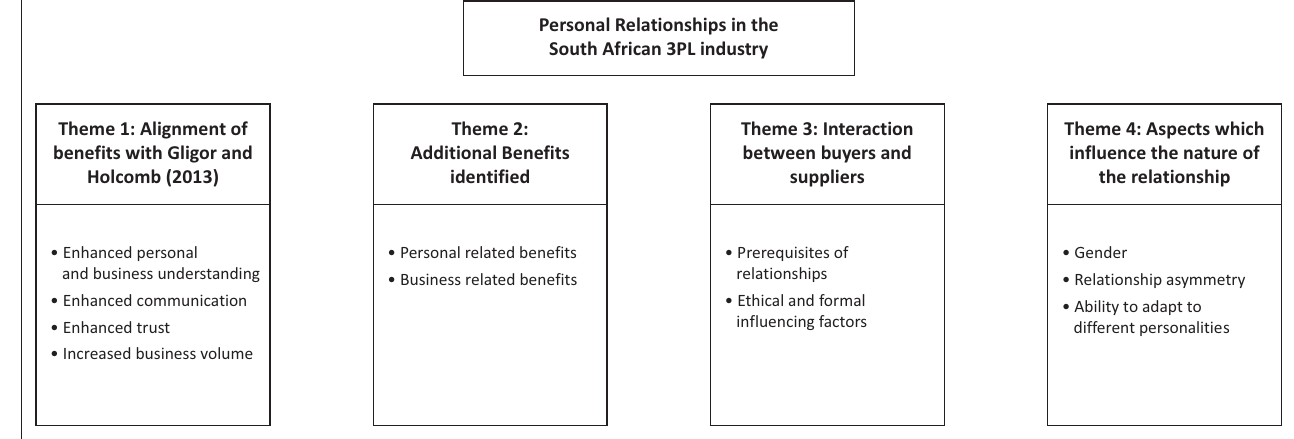
FIGURE 2: Personal relationships in the South African third-party logistics